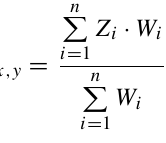
HAND map are relative to the nearest drainage channel. This drainage-normalized representation of the topography has a clear advantage for riverine flood extent mapping, as water depths over land can easily be related to water levels in the river. By using a HAND map instead of a DTM, river slopes are filtered from the dataset. This means that HAND values in an area are directly related to river stage and HAND contour lines describe the flood extent at a specific river stage. Since river slopes are filtered, upstream observations are also less likely to cause overestimations of water levels